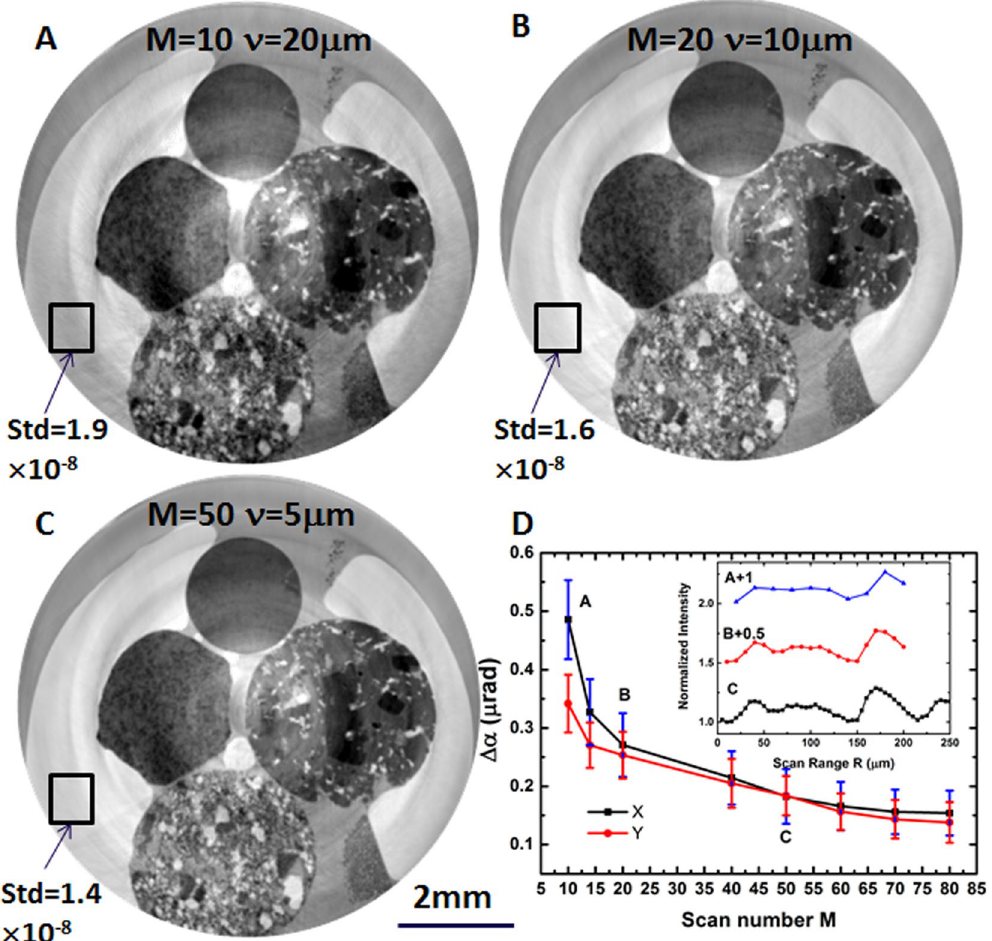
Figure 4. Comparison of reconstructed phase slice with different numbers of modulator scans ( A ) M = 10, ( B ) M = 20 and ( C ) M = 50 using the proposed fly-scan tomography. ( D ) The angular sensitivity as function of modulator scan number M. Inset of ( D ) is the speckle normalized intensity as function of M, the number of scans. The scale bar corresponds to 2 mm. Top sample is fine-grained rhyolite, left is coarser rhyolite, right is picrite, bottom is